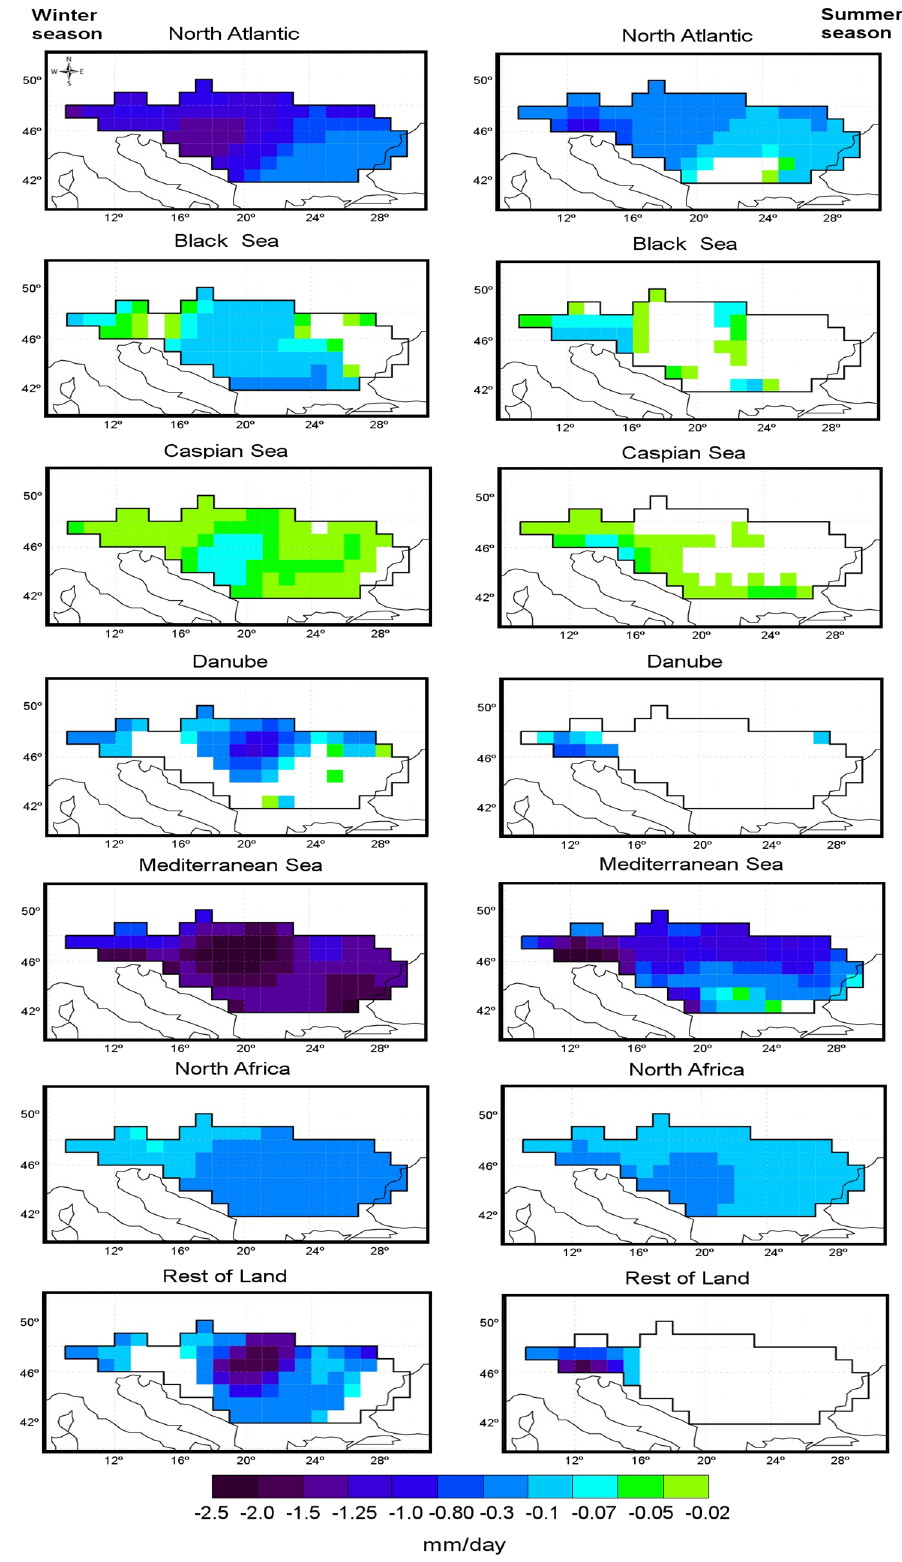
Figure 8. Seasonal average values of E-P < 0 for the period 1980–2014 determined from the forward Lagrangian experiment for: NATL, BS, CS, DRB, MED, NAF, and Rest of Land. The left-hand panels relate to the winter, while the right-hand panels relate to the summer months. Only negative values are shown to reflect sink regions. The thick black line delimits the DRB area. Scale is mm/day.